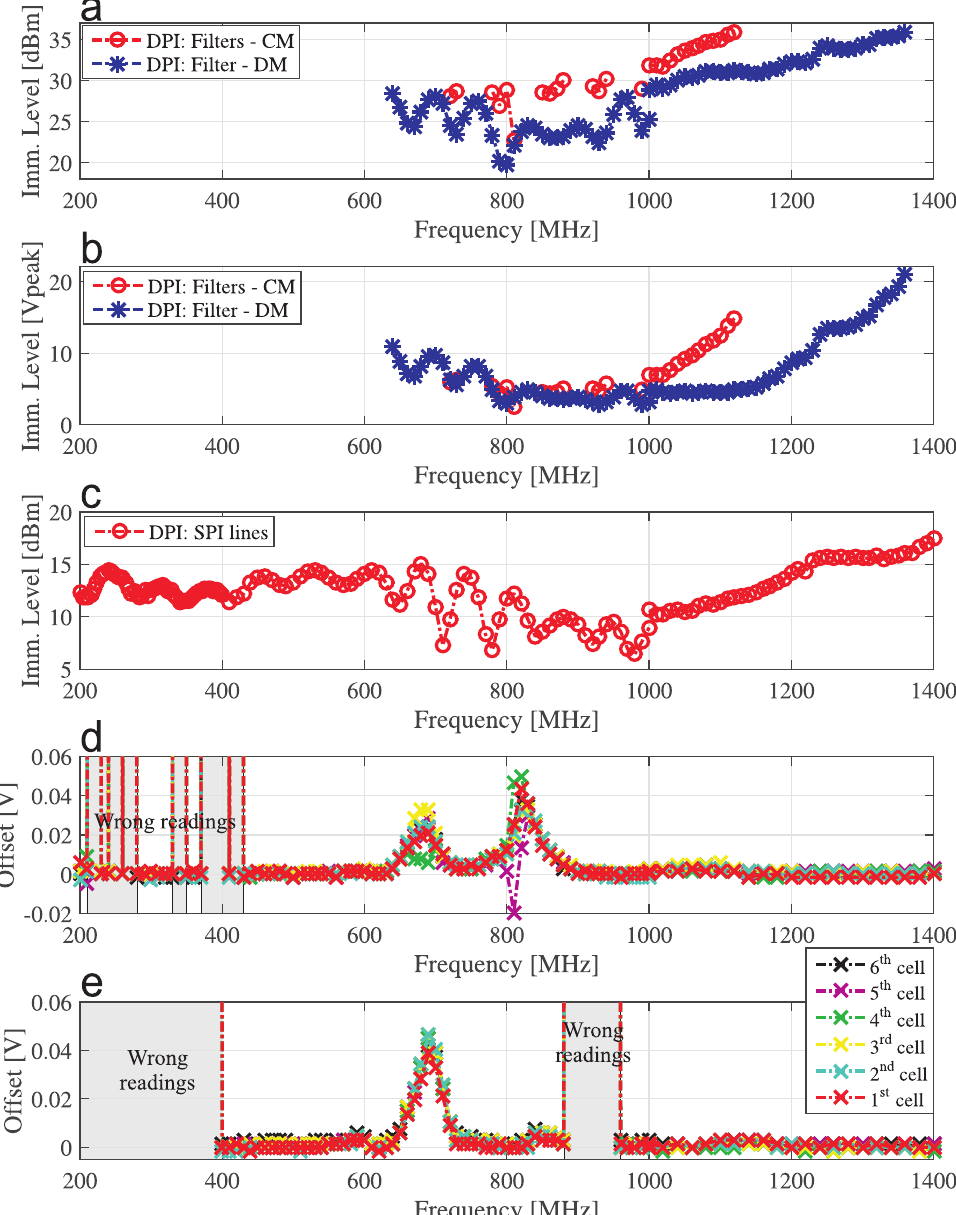
Figure 17. ( a ) Measured immunity level for DPI on the cell input pins: differential (DM) and common-mode (CM) injection, with 100 Ω , 100 nF RC filters in Figure 2, and ( b ) respective EMI peak amplitudes. ( c ) Measured immunity level for DPI on the four SPI lines. ( d ) EMI-induced offset in the acquired cell voltages, E = 200 V/m. Vertical polarization. ( e ) EMI-induced offset in the acquired cell voltages, E = 200 V/m, horizontal